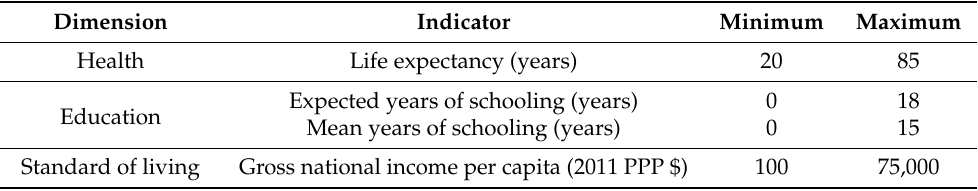
Table 1. Variables and parameters of the most recent Human Development Index HDI. Dimension Indicator Minimum Maximum Health Life expectancy